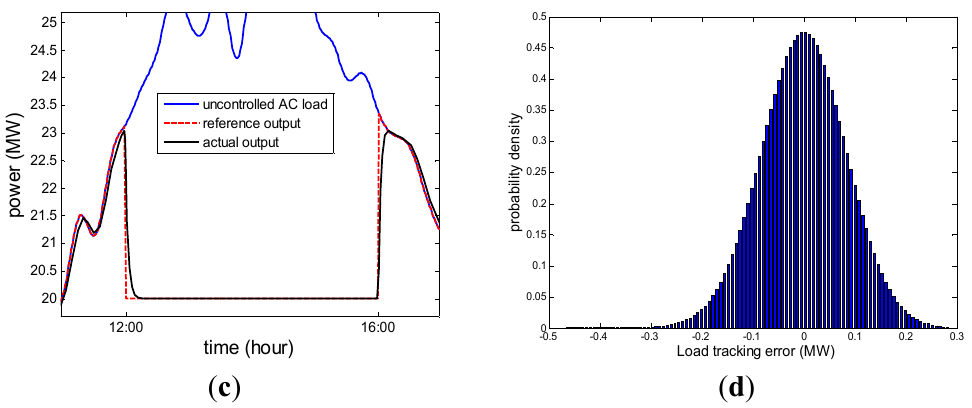
Figure 20. ( a ), ( b ), ( c ) A comparison between the aggregated power of 18,000 ACs without any control, the desired AC load reference value for load shifting, and the actual output power of AC load based on PSO tuning parameters of the PID controller. ( d ) Probability density distribution of the tracking error between the actual output power and the reference value. The model is simulated for a hot day, and the ambient temperature continues to change.